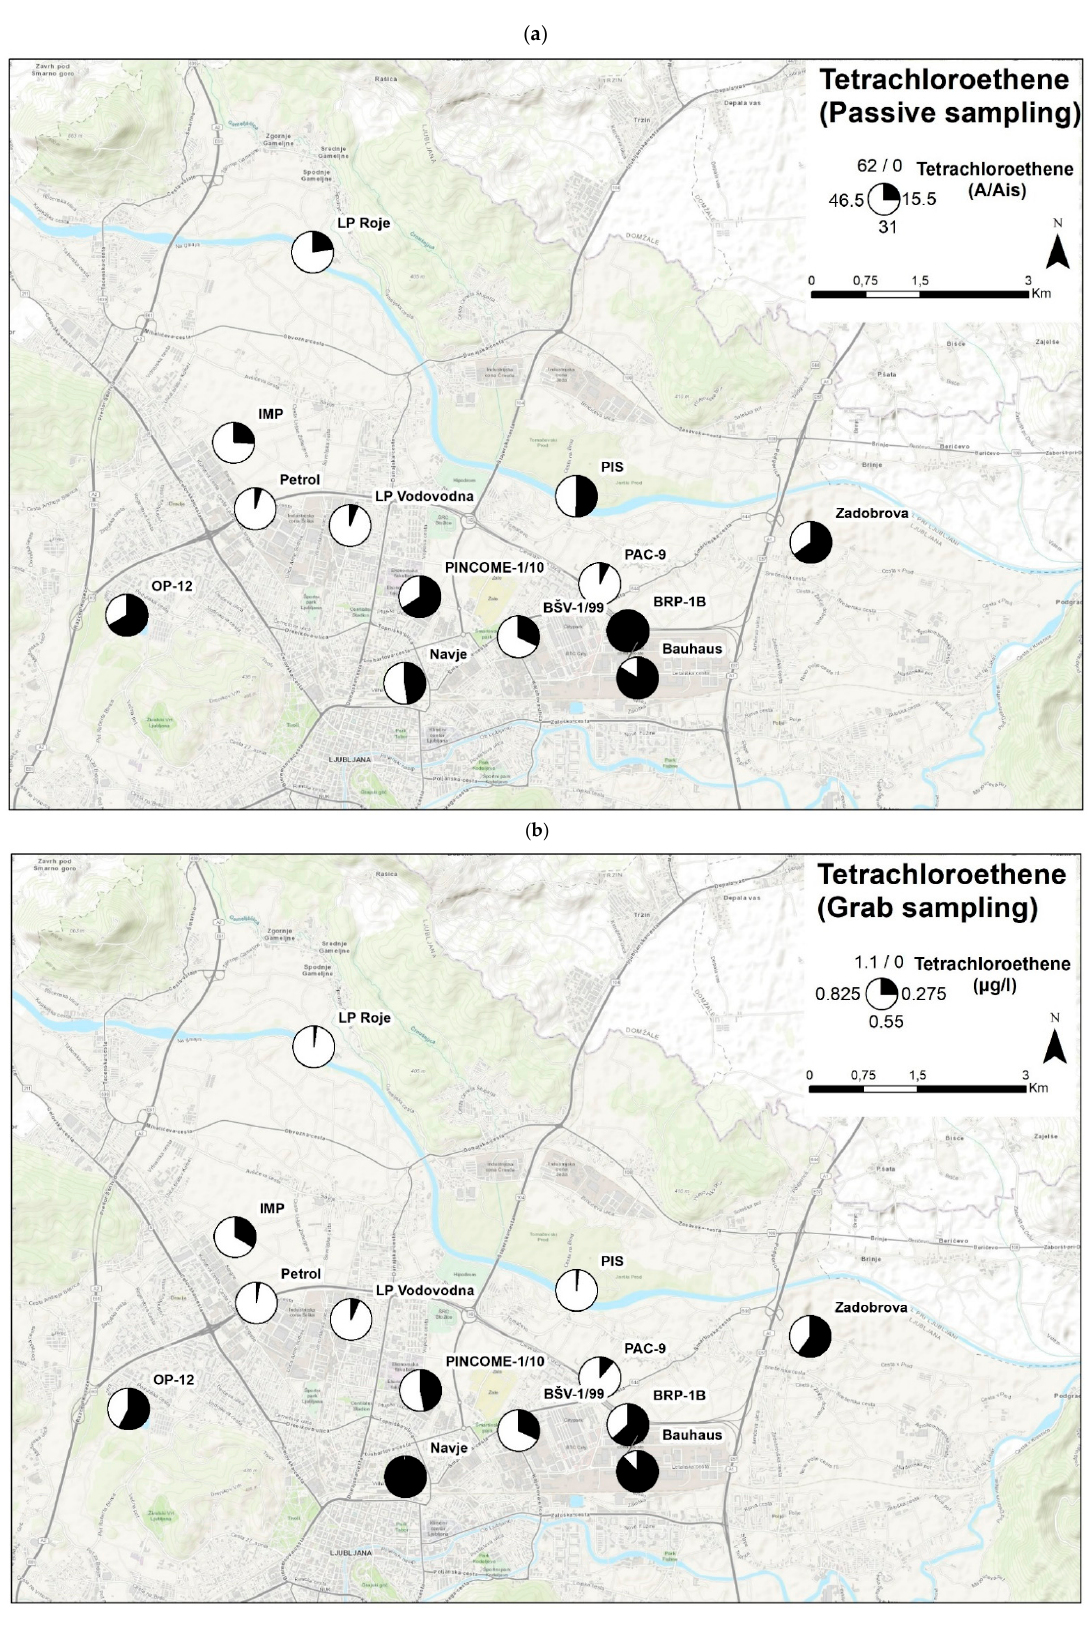
Figure 8. Comparison of results for the distribution of ( a ) tetrachloroethene between passive and ( b ) grab sampling at the Ljubljansko polje aquifer in 2015. Table 6. Comparison of grab and passive samples in the Ljubljansko polje aquifer. Grab Samples (µg/L) Sampling Point